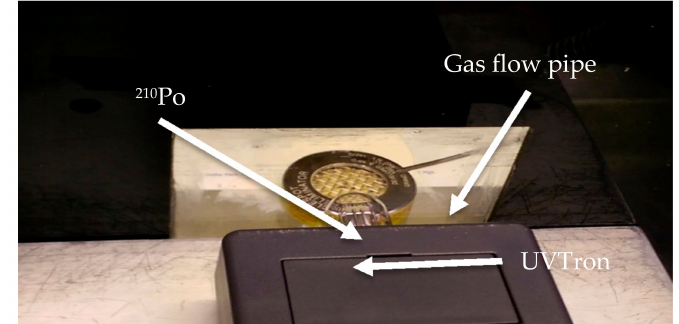
Figure 3. Photograph showing the 210 Po source inside the gas flow box (silver disk with mesh surface and yellow edge), with the gas flow pipe above and to the left. The UVTron (small glass bulb) is external to the box and is attached to the grey box in the foreground which houses the detector electronics.